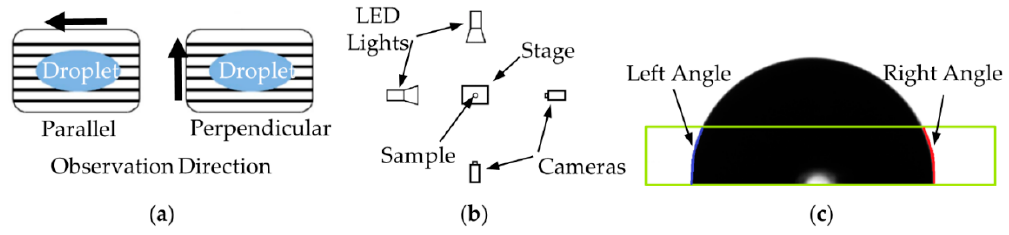
Figure 4. ( a ) Observation direction of the water droplets on the textures surface; ( b ) layout of the wetting test setup; ( c ) estimation of the contact angles through the fitting of the droplet shape. The green square defines the searching area that the software keeps.